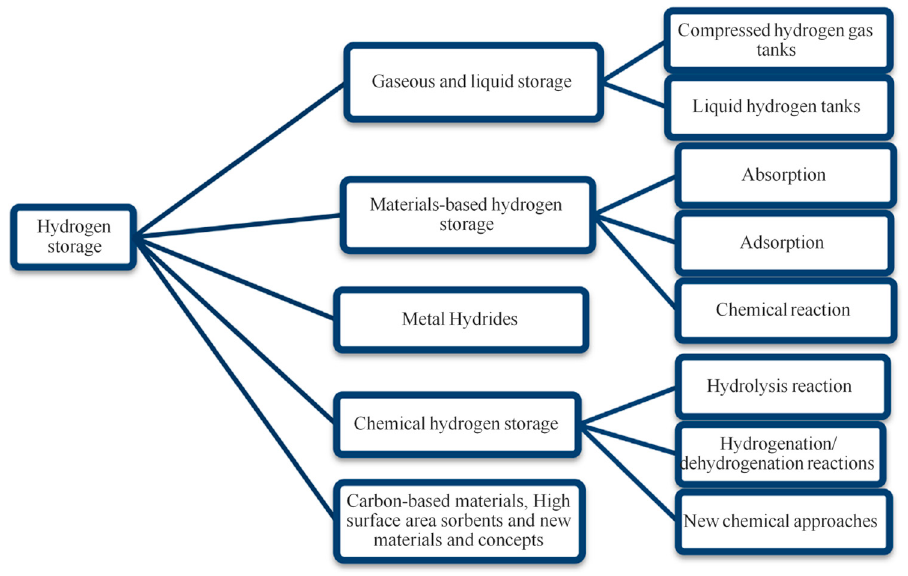
Figure 2. Hydrogen storage methods (reproduced from [62] with permission from Elsevier).